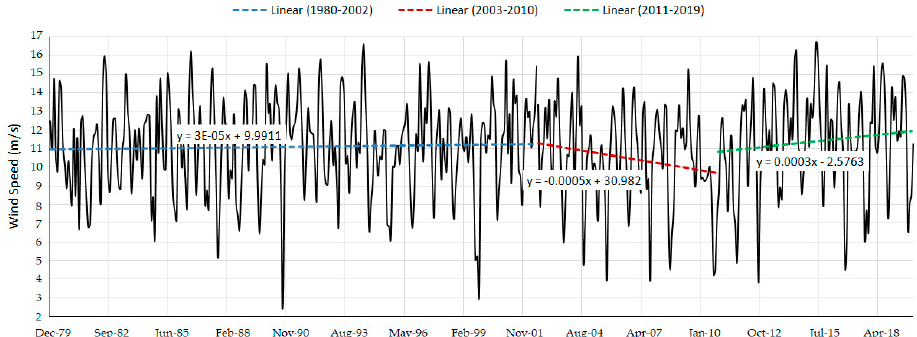
Figure 4. Time series of CLLJ (925 hPa) between 1980–2019 indicating linear trends.